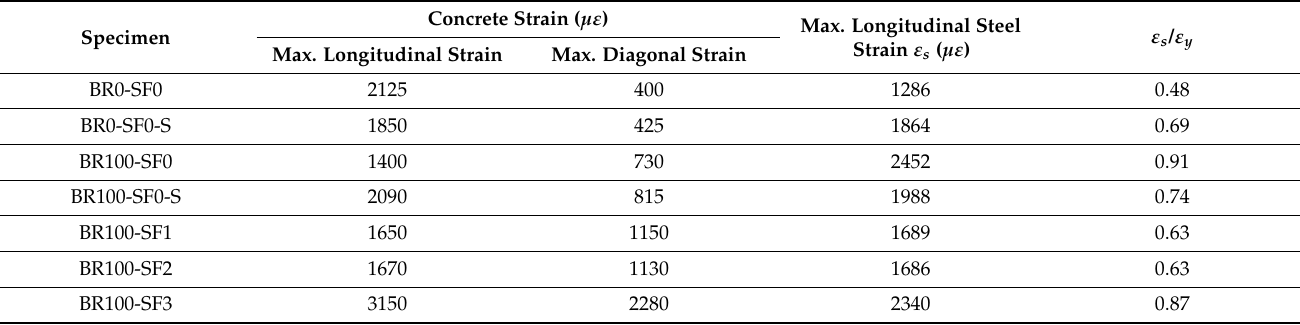
Figure 8. Steel strain profile: ( a ) BR0-SF0; ( b ) BR0-SF0-S; ( c ) BR100-SF0; ( d ) BR100-SF0-S; ( e ) BR100-SF1; ( f ) BR100-SF2; and ( g ) BR100-SF3. Table 6. Strain measurements at shear capacity.